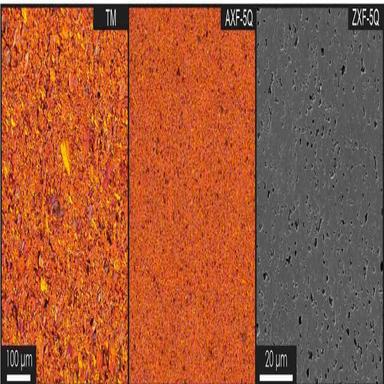
Polarized (TM, AXF-5Q) optical micrographs and SEM (ZXF-5Q) of POCO graphite grades.